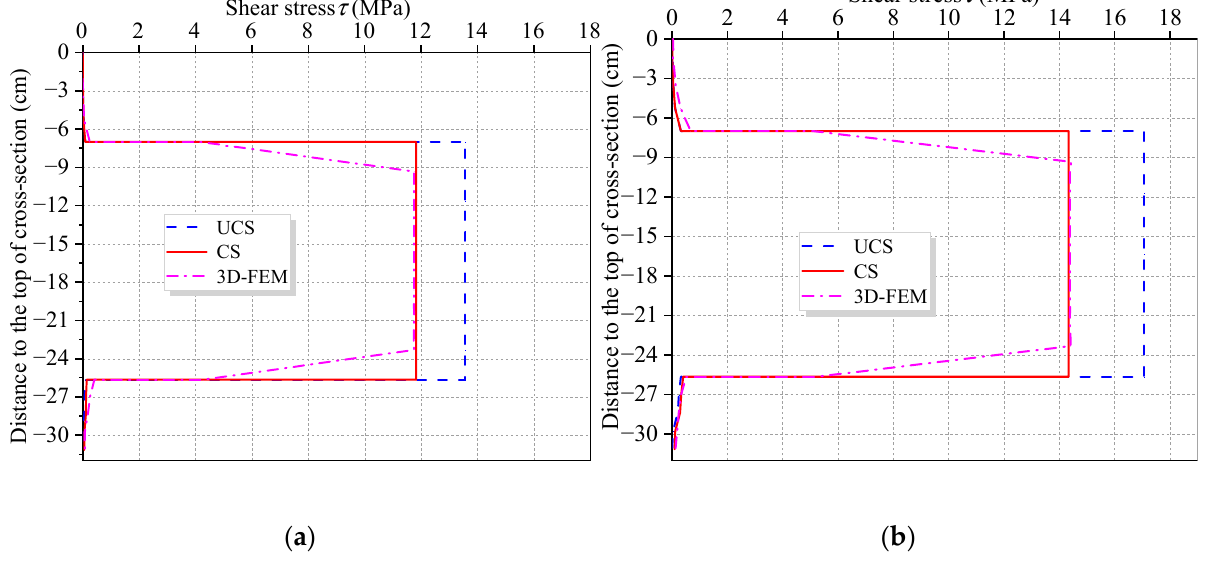
Figure 18. Vertical distribution of shear stress along section B-B under different load cases: ( a ) Case 1; ( b ) Case 2.